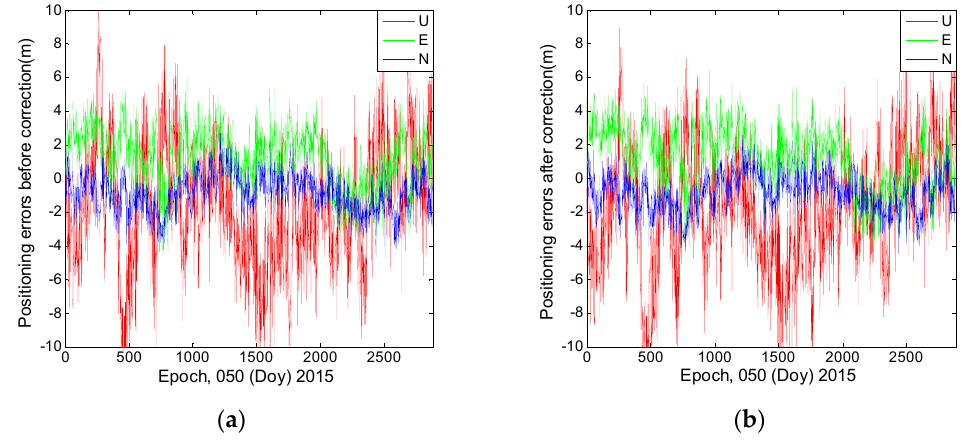
Figure 16. The SPP results estimated by using ionosphere-free combination of the first and second frequencies at station CUTO. ( a ) Represents the positioning errors before applying the correction model; ( b ) Represents the positioning errors after applying the correction model.